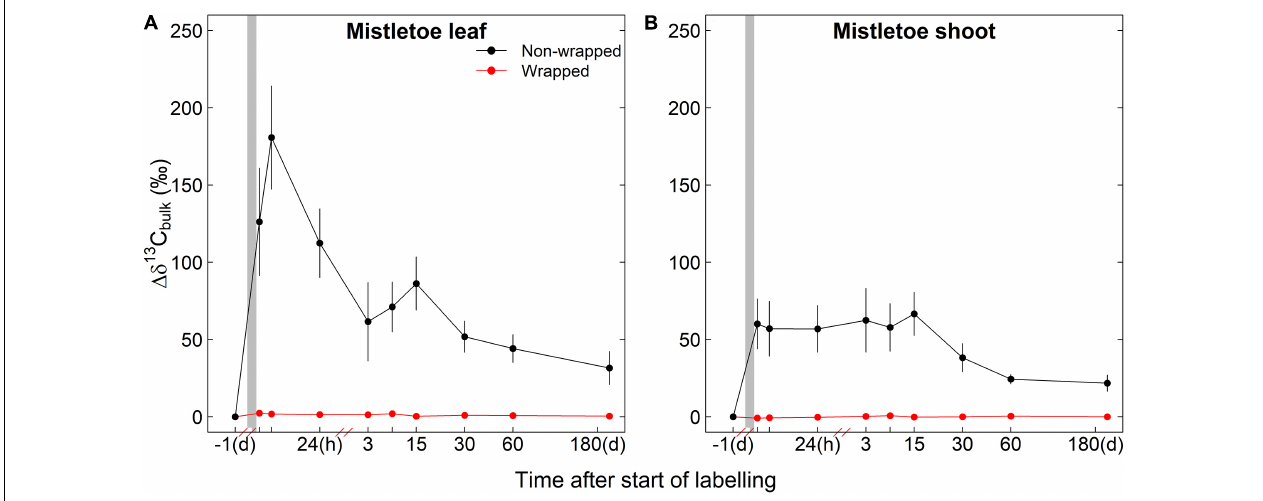
FIGURE 3 | Incorporation of the 13 C label into the bulk organic matter ( (cid:49) δ 13 C bulk ) of mistletoe leaves (A) and shoots (B) in the wrapping experiment (i.e., wrapped vs. non-wrapped; n = 3) after a 3.5 h of exposure to 13 C-enriched CO 2 (gray shaded area). Please note that the initial point is from 1 day before the labeling and that the scaling of the x -axis changes after each